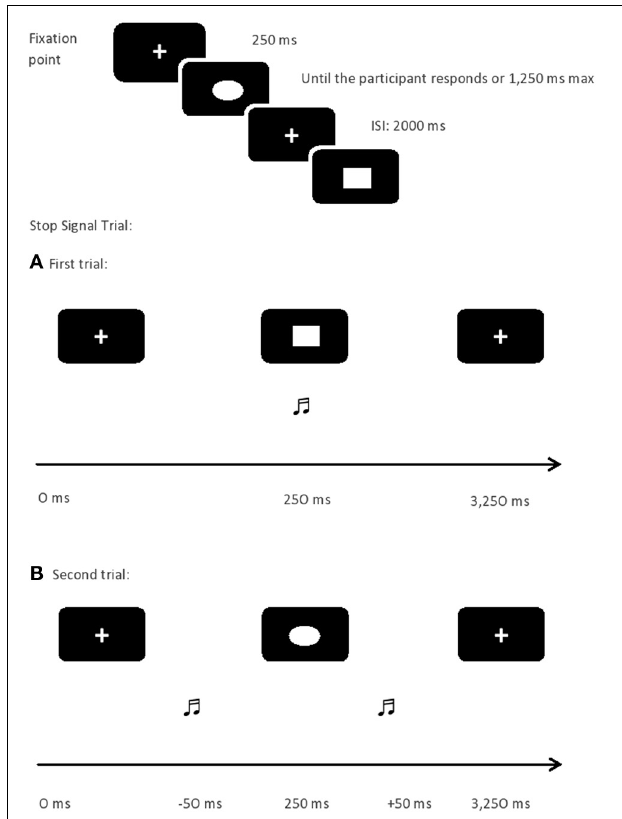
FIGURE 1 | Stop Signal Task design. Note: ISI, Inter Stimulus Interval; ms, milliseconds.